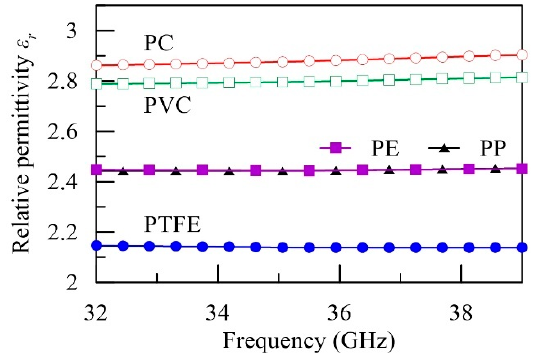
Figure 4. Relative permittivity of the low-loss materials.